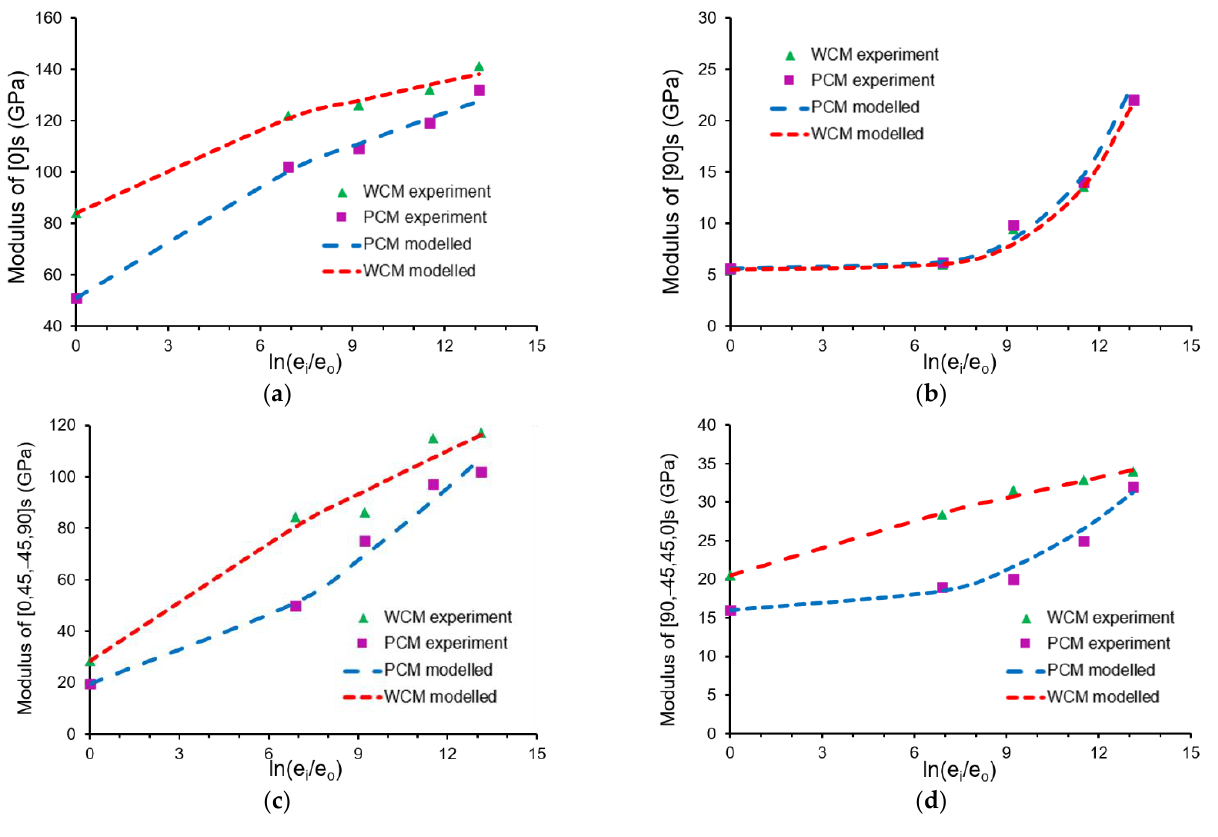
Figure 7. Effect of strain rate on tensile strength of different configurations: ( a ) (0)s; ( b ) (90)s; ( c ) [0/45/−45/90]s; ( d ) [90/−45/45/0]s.